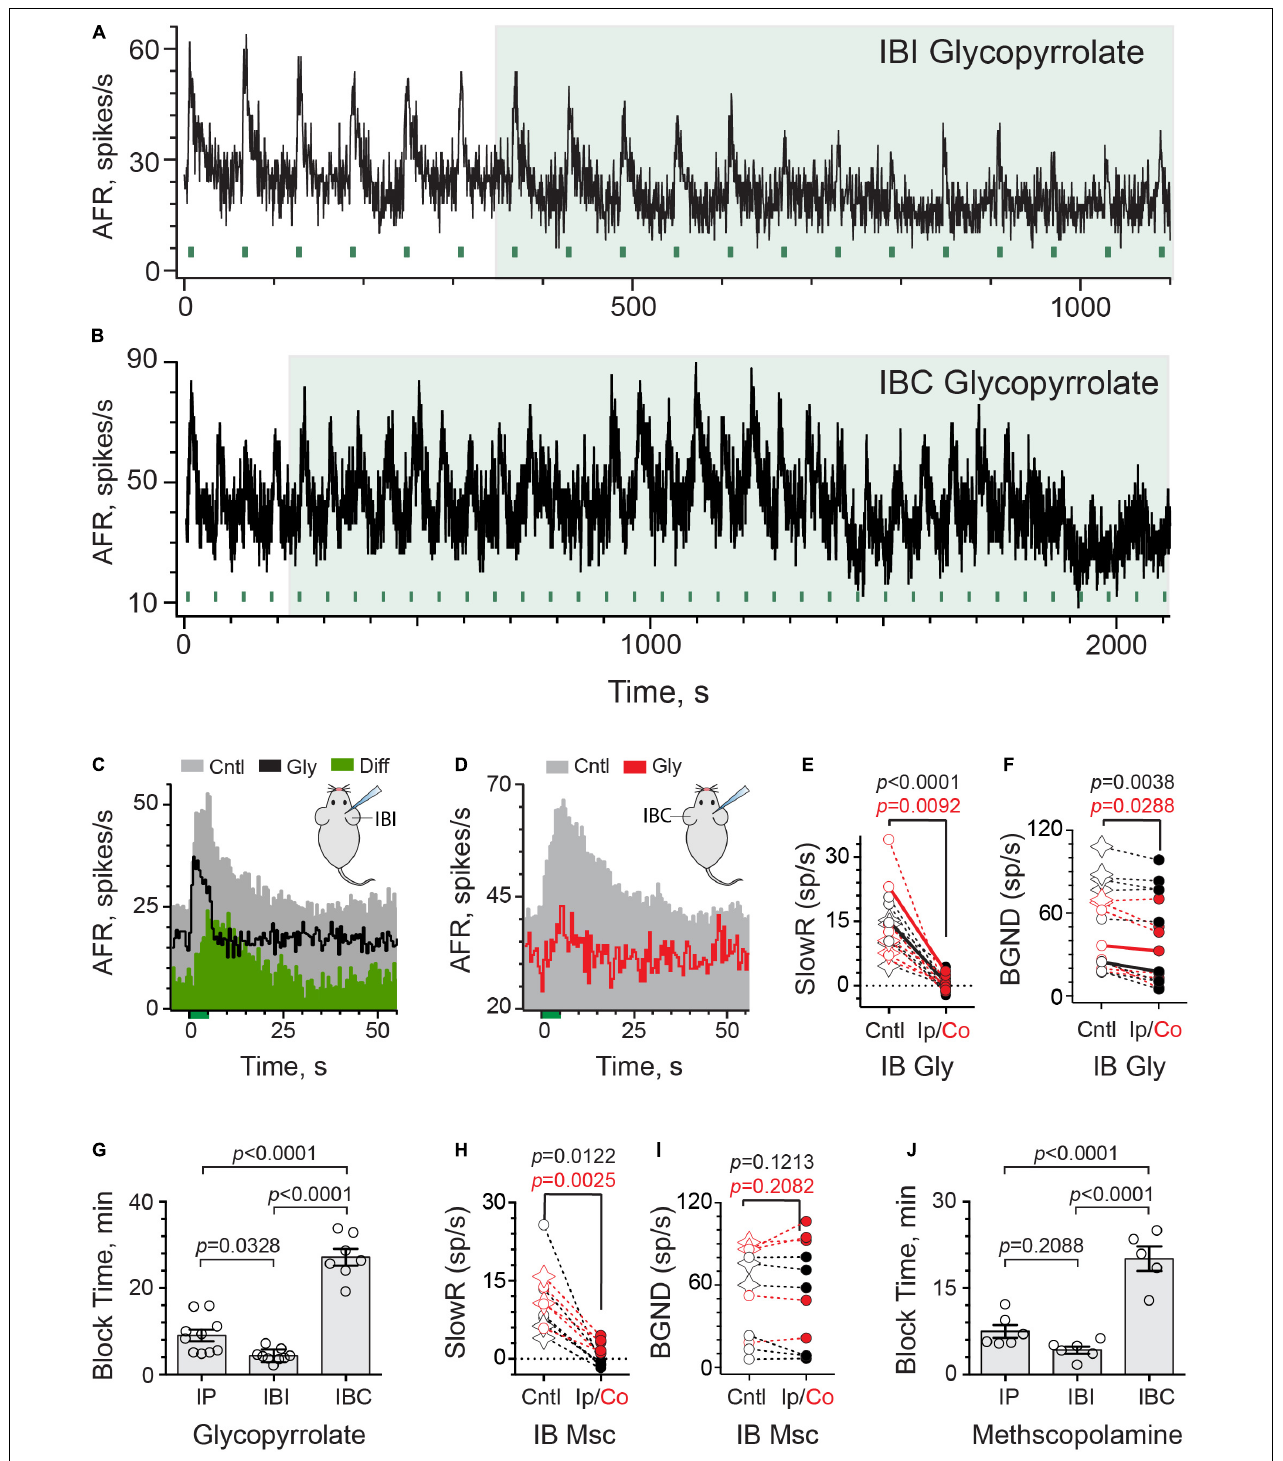
FIGURE 3 | Intrabulla application of glycopyrrolate and methscopolamine also blocks efferent-mediated slow excitation in mouse vestibular afferents. (A) Continuous response histogram from an irregular afferent shows changes in afferent firing rate (AFR) during midline efferent stimulation (green bars, 333/s for 5 s every 60 s) before and after the ipsilateral intrabulla delivery of glycopyrrolate (30 µ l at 0.5 mM), starting at t = 360 s (green box). (B) Continuous response histogram from an irregular afferent shows changes in afferent firing rate (AFR) during midline efferent stimulation (green bars, 333/s for 5 s every 60 s) before and after the